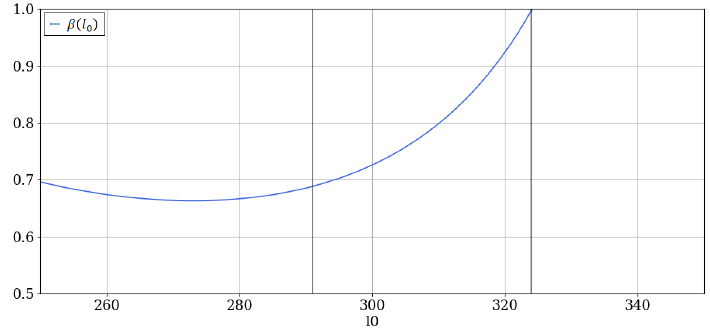
Figure 8. 𝛽 as function of 𝑙 0 : 𝑙 0 between 250 and 350 m , with a fixed 𝑙 1 = 200 m and 𝑙 𝑑 = Figure 8. β as function of l 0 : l 0 between 250 and 350 m, with a fixed l 1 = 200 m and l d = 0.008 0.008 m .